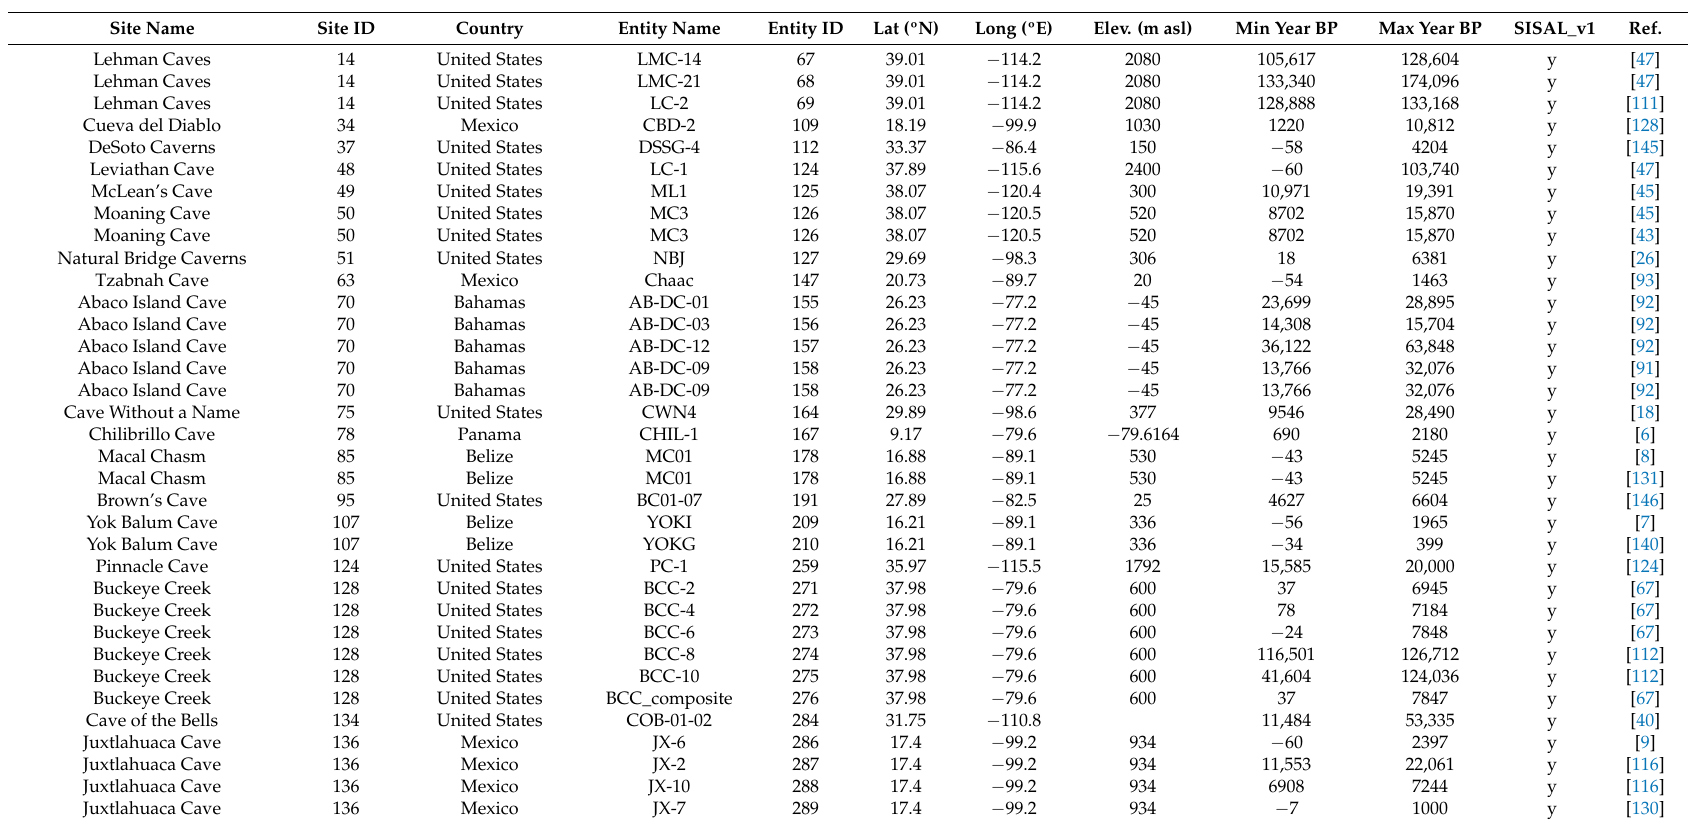
Table 1. Identified North and Central American speleothem